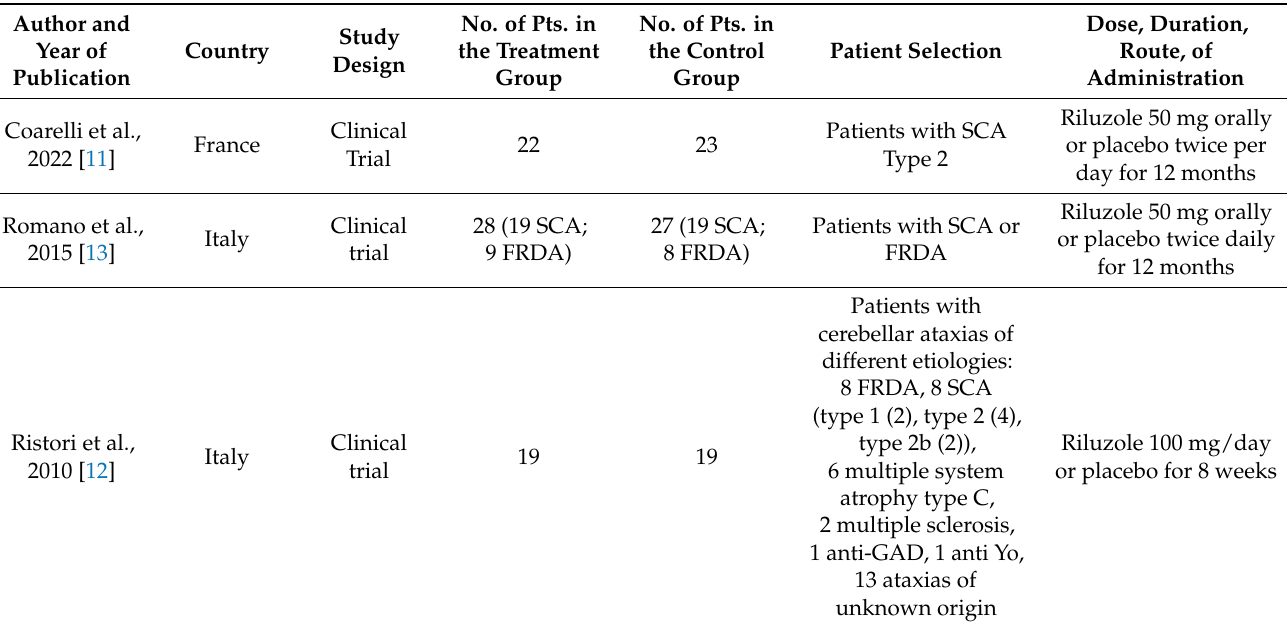
Table 2. The characteristics of clinical trials used in the systematic